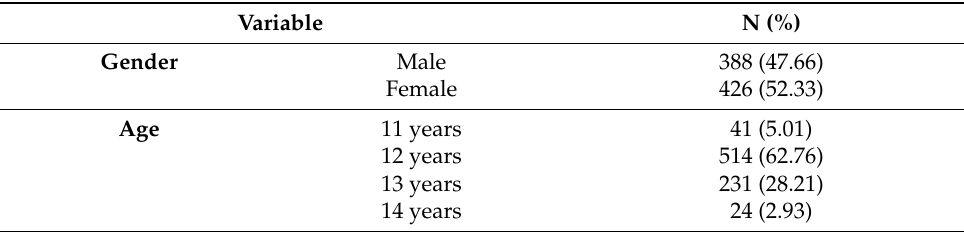
Table 1. Sample description according to gender and age.